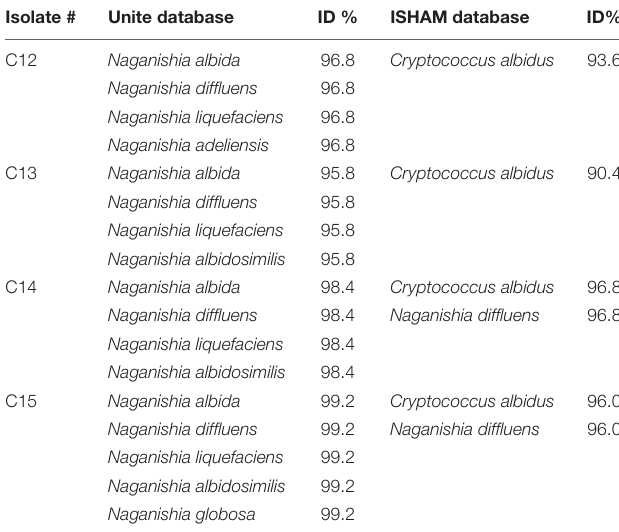
TABLE 2 | Species identification using the UNITE ITS database and ISHAM ITS